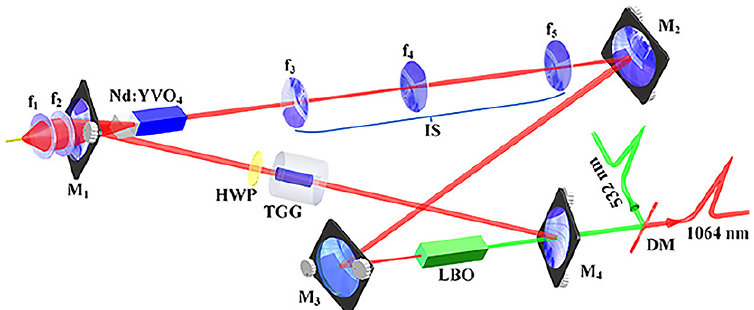
Figure 25. Schematic of the experimental setup [35]. Reprinted with permission from [35] c (cid:13) The Optical Society.